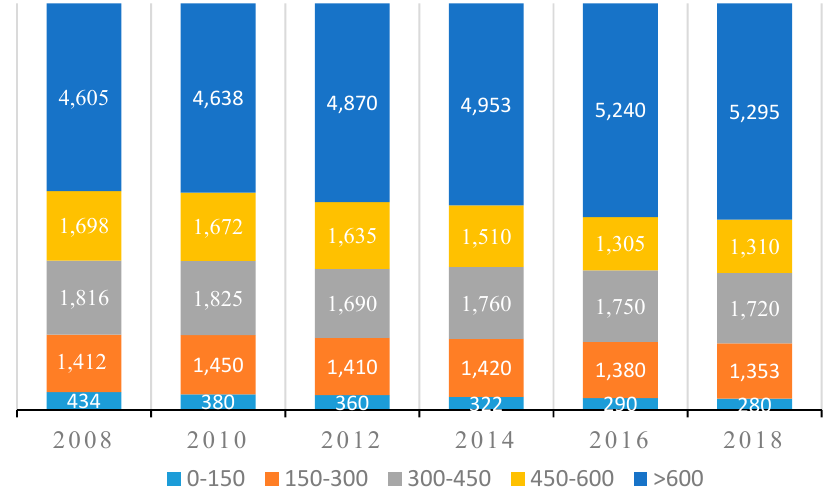
Figure 8. Temporal changes in groundwater table depths in the Punjab province (Source: SCARP Monitoring Organization).